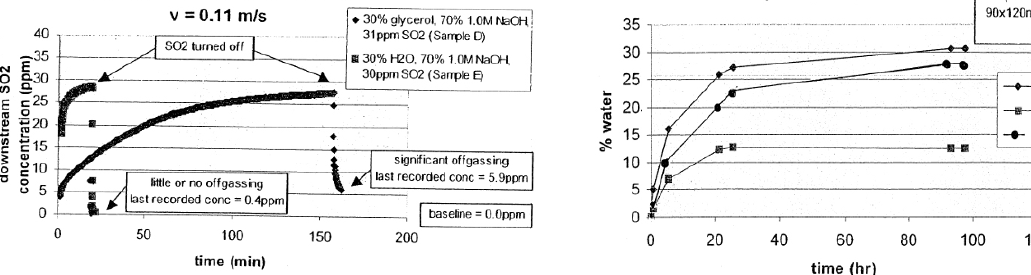
Figure 12. Uptake of water at 25 o C and 50% RH by different coating